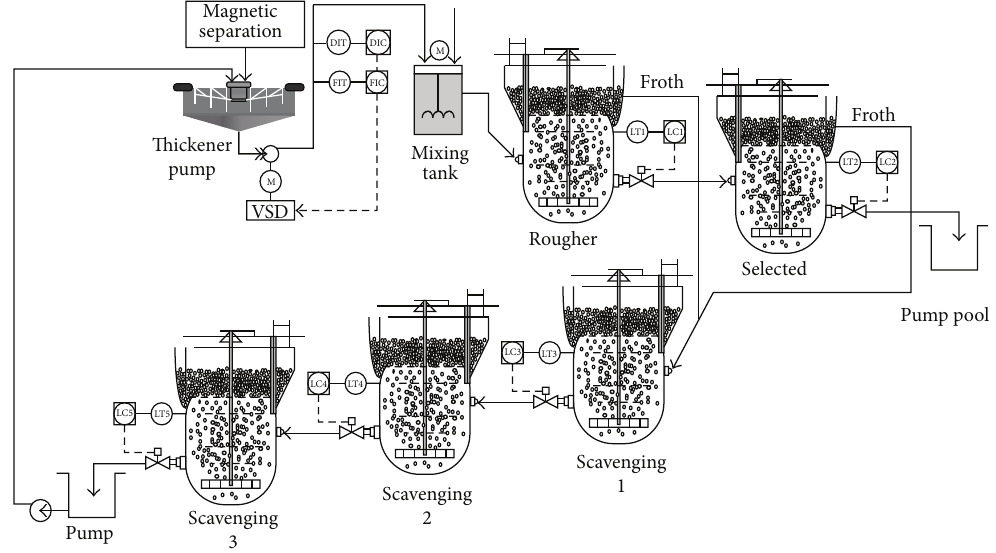
Figure 2: Technique flowchart of flotation